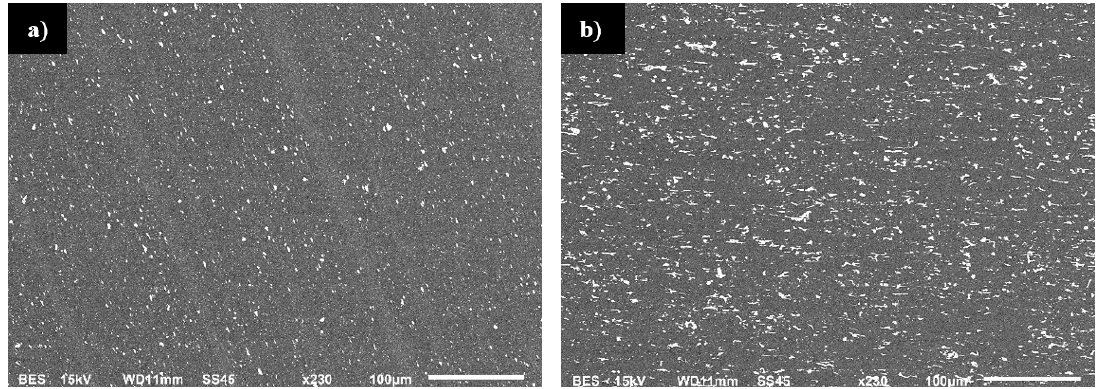
Figure 13. Scanning electron microscopy images of the ( a ) stir zone and ( b ) base material.